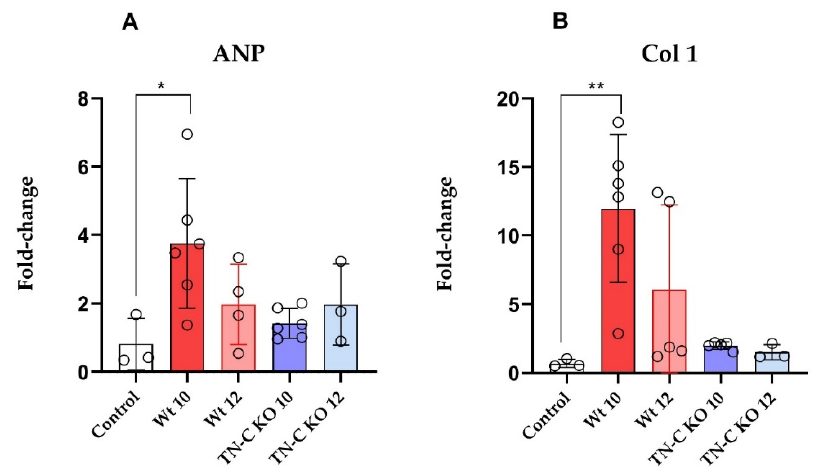
Figure 5. ( A ) Relative fold changes of mRNA expression of atrial natriuretic protein (ANP) and ( B ) collagen 1 (Col 1) between Wt and TN-C KO groups and timepoints (10 and 12 weeks); * p < 0.05, ** p < 0.01, n = 3–7/group. Wild-Type 10 weeks (Wt 10), Wild-Type 12 weeks (Wt 12), Tenascin-C knockout 10 weeks (TN-C KO 10), and Tenascin-C knockout 12 weeks (TN-C KO 12) mice.